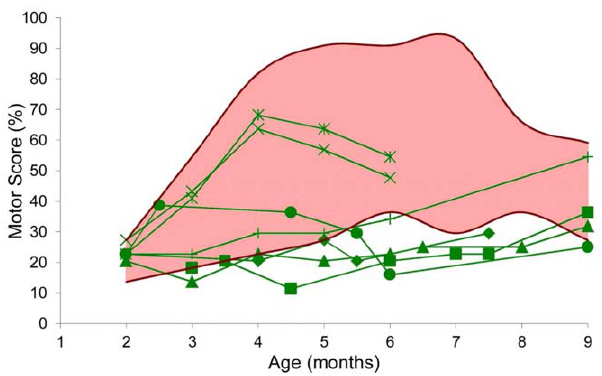
Figure 5. Evolution of the motor score during the treatment. This graph represents the longitudinal evolution of the motor score of the treated dogs (green, individual symbols provided in table 1), in comparison with the range (pink area) of values (dark red curves=min and max) obtained in a population of 24 untreated GRMD dogs, during the treatment period (2 to 9 months). Two features are uncommon and